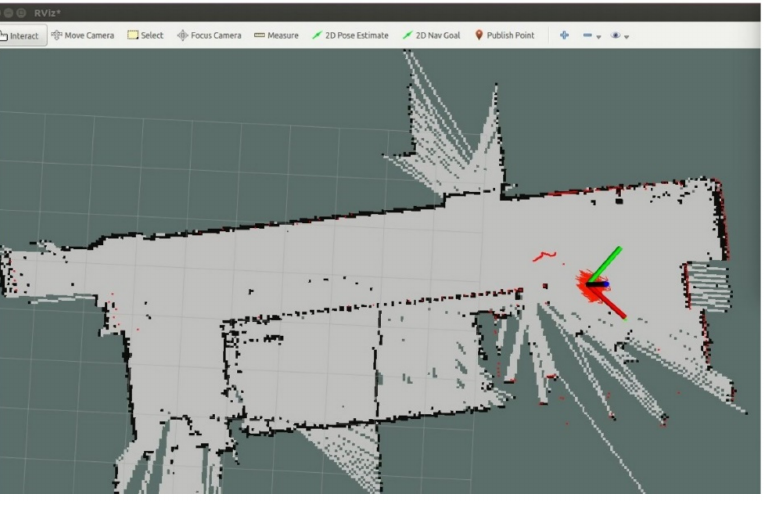
Figure 30. RVIZ simulation environment of